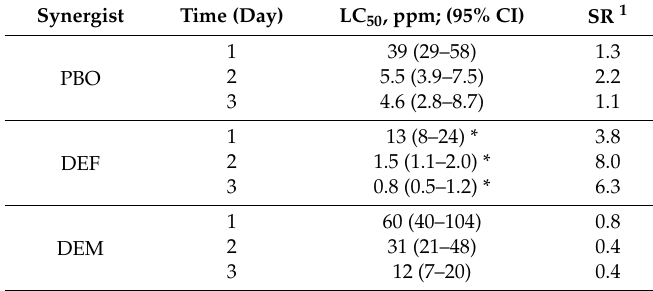
Table 4. Effects of synergists in feeding assays of fluralaner against Ae. aegypti adult females.